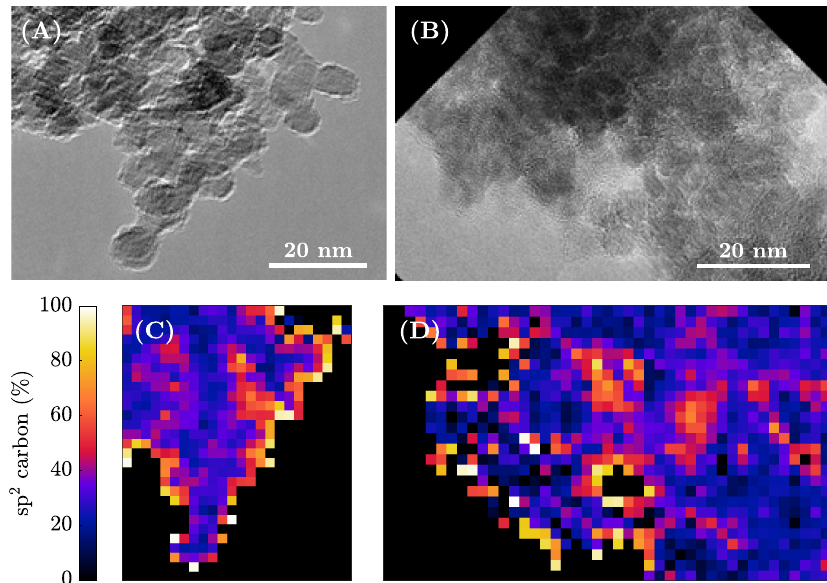
Figure 2. STEM images of ( A ) H 2 gas annealed and ( B ) H 2 plasma treated DND particles and EELS maps ( C , D ) of the same regions showing the sp 2 /sp 3 fraction as a percentage of sp 2 -hybrydized carbon. The image background is black. Measurements were performed at 80 keV accelerating